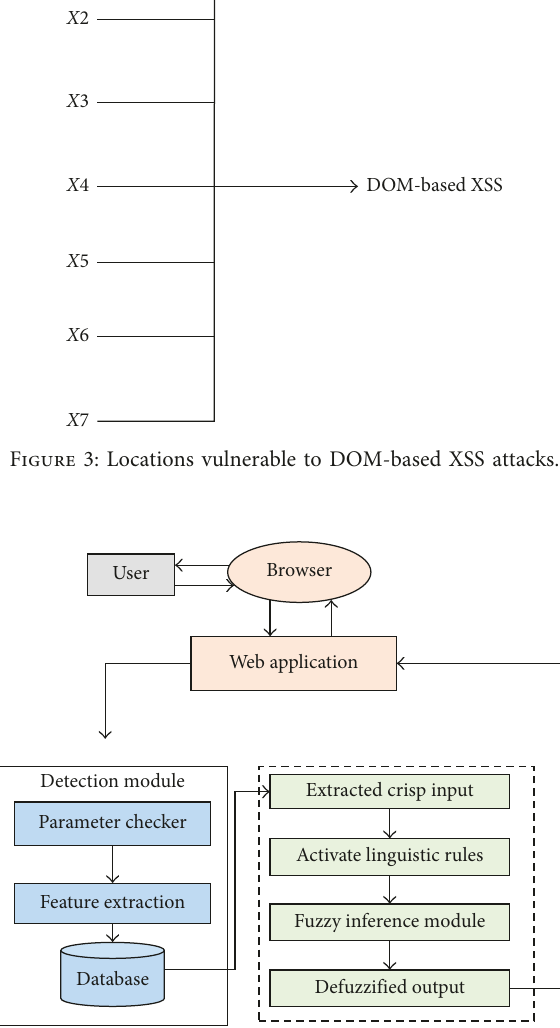
Figure 4: System architecture.